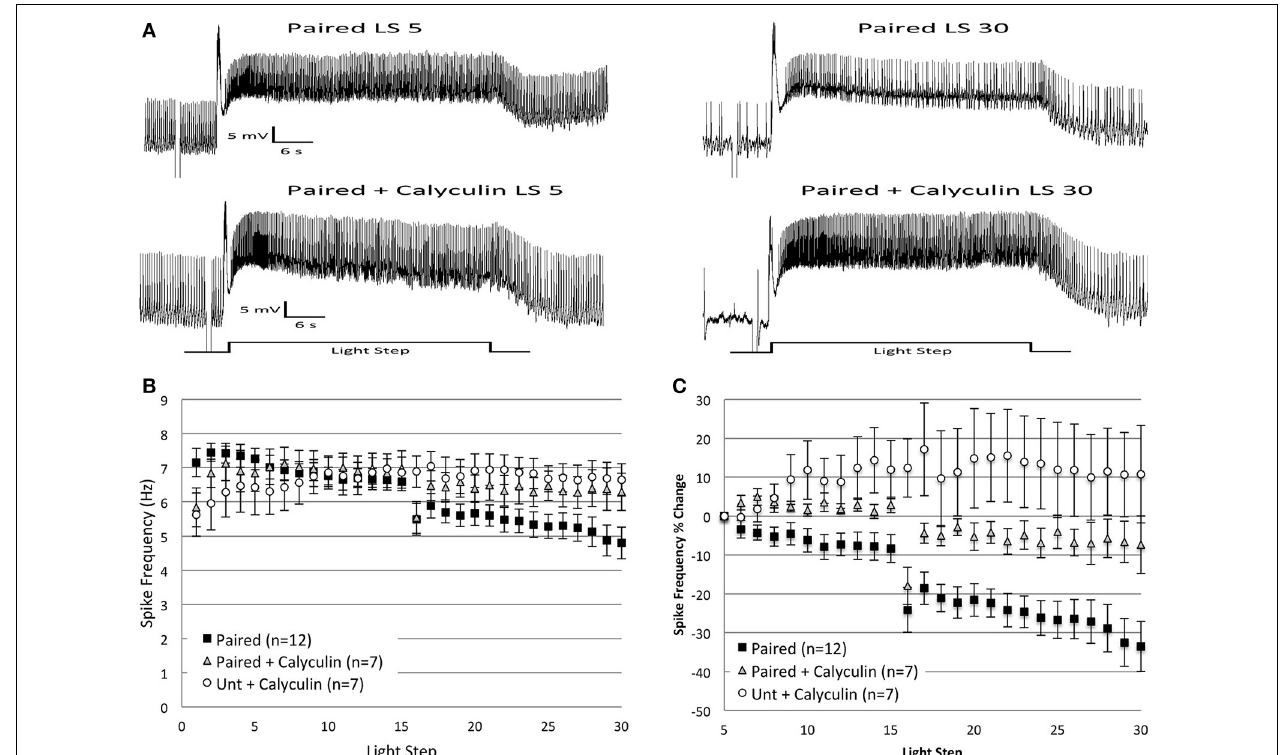
FIGURE 4 | Bath application of calyculin A (20nM), an inhibitor of PP1, blocked the reductions in spike frequency produced by repeated LSs in Paired cells, when measured as a percent change in spike frequency. (A) Representative light responses recorded from a Paired Type B cell (top trace) or a Paired cell incubated in calyculin A ( Paired + Calyculin ; bottom trace) for 15min prior to in vitro extinction. The Paired cell showed a significant decline in light-evoked spike frequency (40%) from the 5th to 30th LS, while the Paired + Calyculin cell showed a 21% increase. (B) Summary spike frequency data of Type B cells exposed to calyculin A. The large reduction in spike frequency observed in Paired (no drug) cells during LSs 16–30 was qualitatively smaller when Paired cells were incubated in